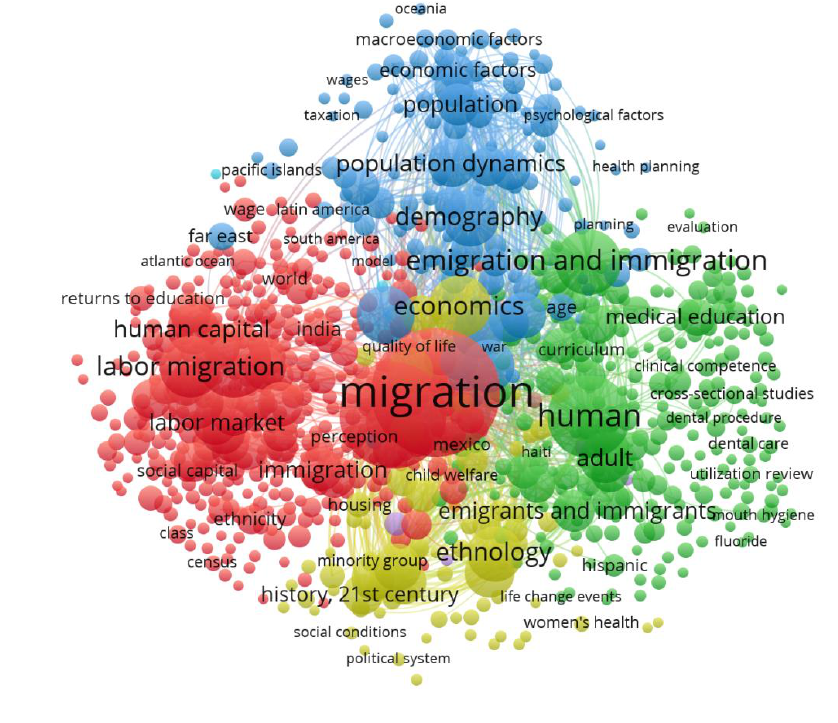
Figure 4. The visualizing map of co-occurrence of the keywords in papers of a dataset (initial search query of the keywords “education” AND